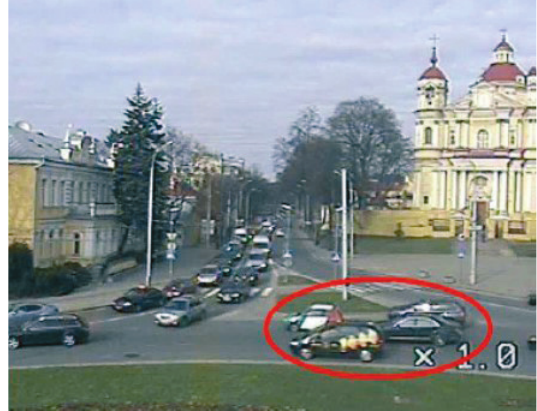
Figure 4. Car drivers do not follow traffic